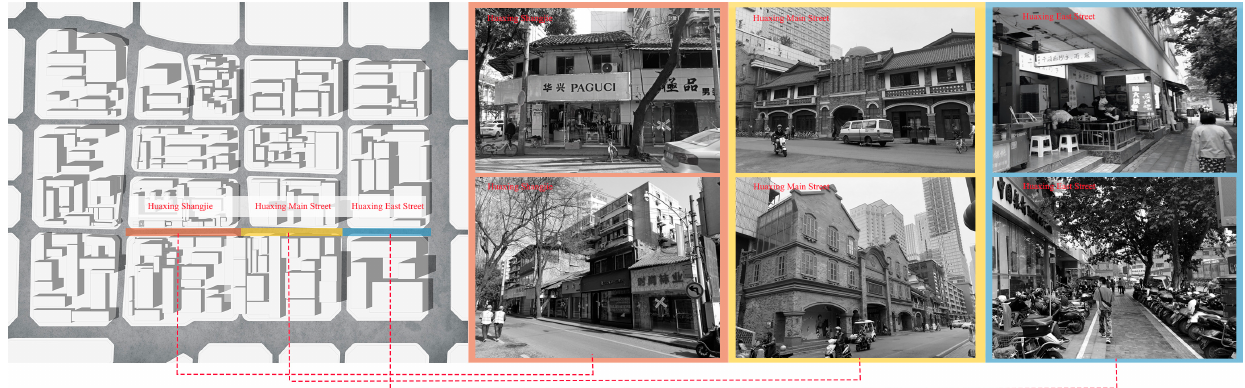
Figure 4. Current Situation of Investigation and Research on Huaxing Upper Street, Huaxing Centre Street, and Huaxing East Street.